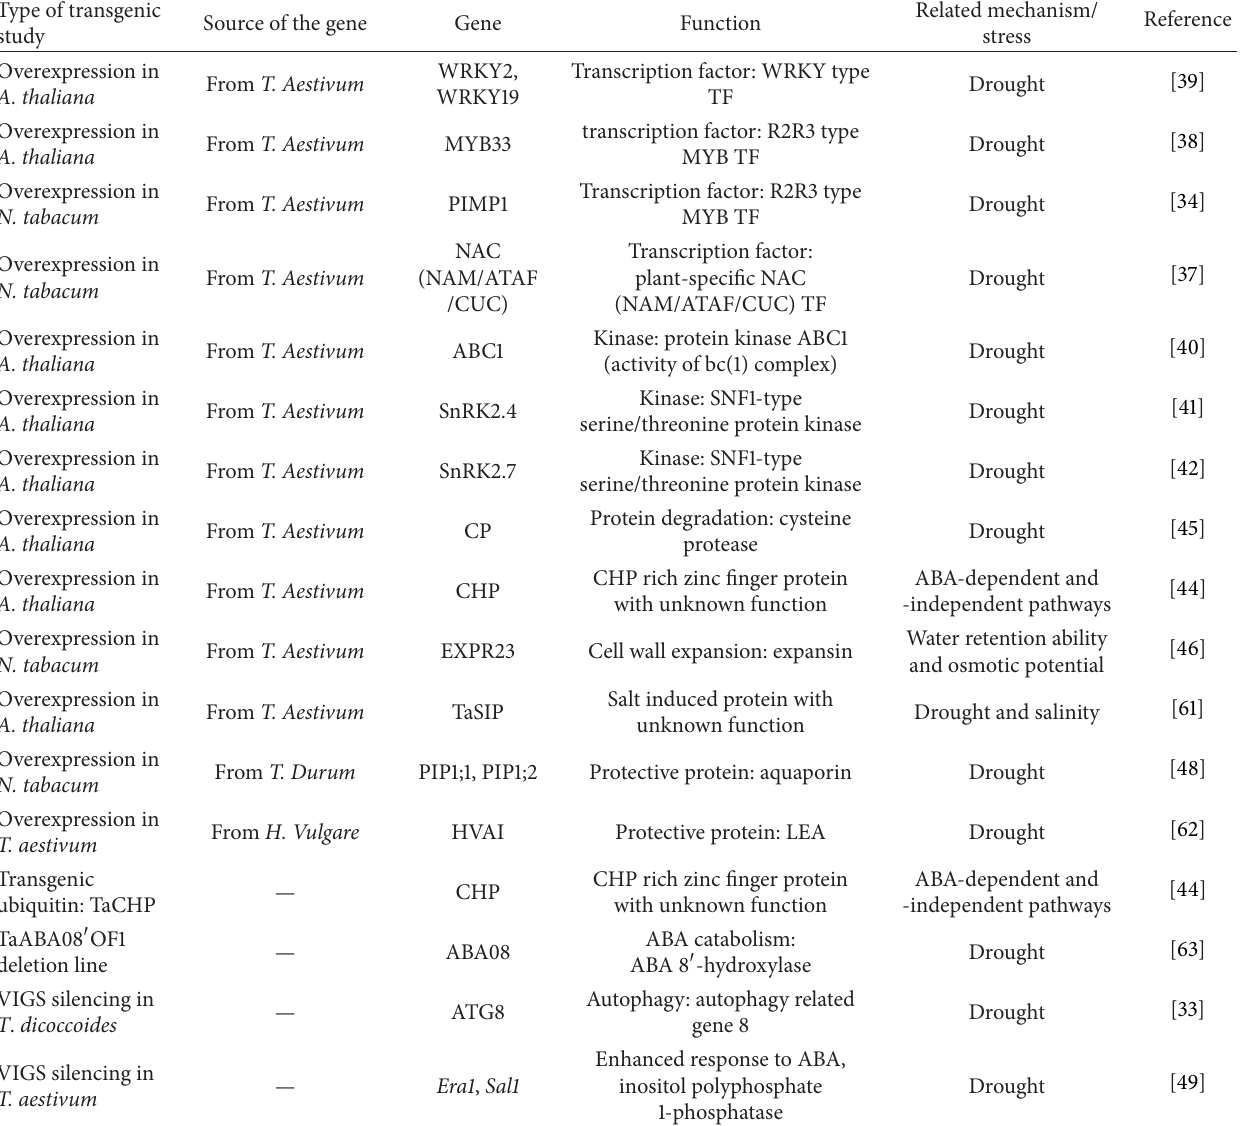
Table 3: List of genes confirmed to function in drought by transgenic studies in last three